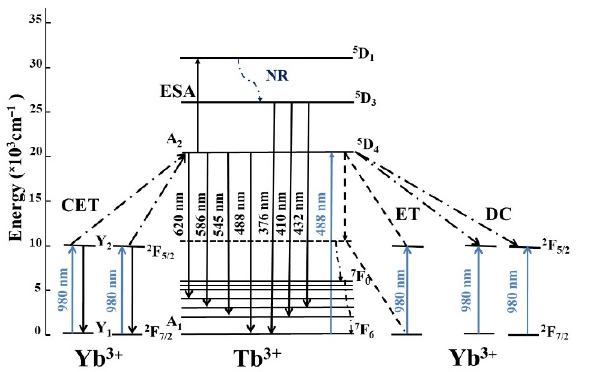
Figure 1. Energy level diagram of Yb 3+ and Tb 3+ ions co-doped phosphate glass showing the possible mechanism of energy transfer processes.